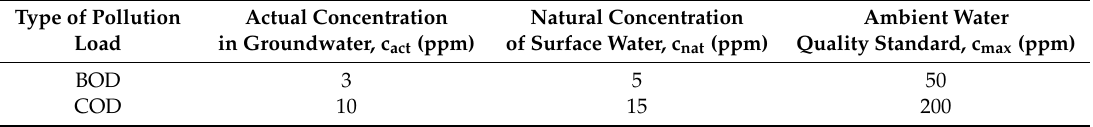
Table A17. Pollution load concentration in groundwater, surface water and ambient water quality standard [190,191].